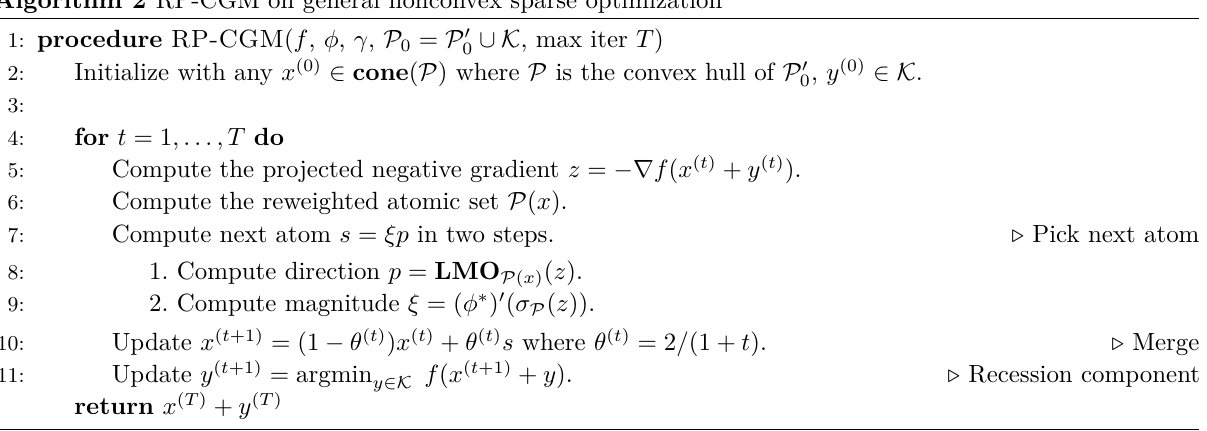
Algorithm 2 RP-CGM on general nonconvex sparse